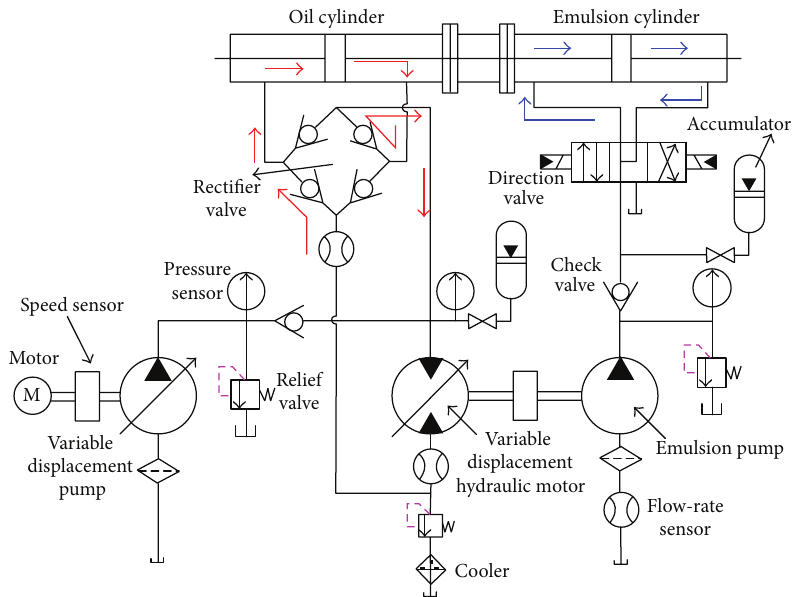
Figure 1: Schematic diagram of the novel energy regenerative